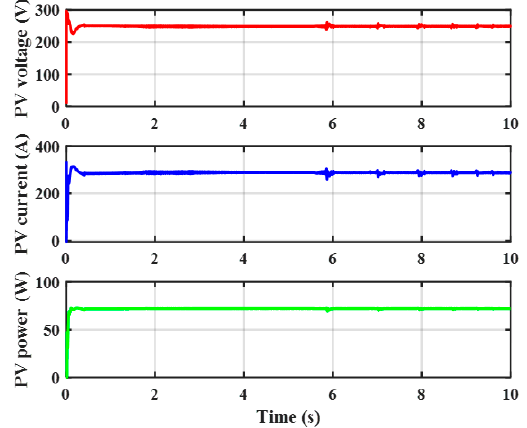
Figure 13. PV panel parameters.